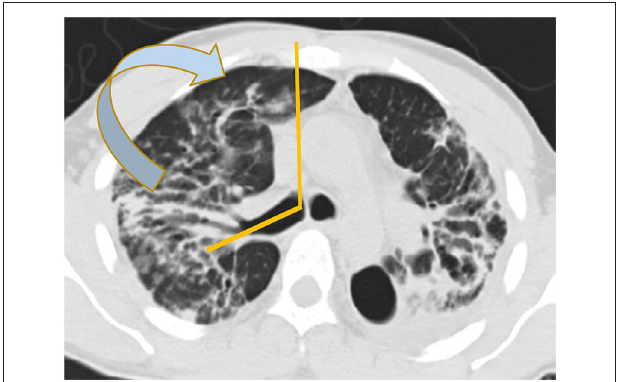
FIGURE 6 | Non-fibrotic sarcoidosis with pulmonary nodules in a peri-lymphatic distribution.